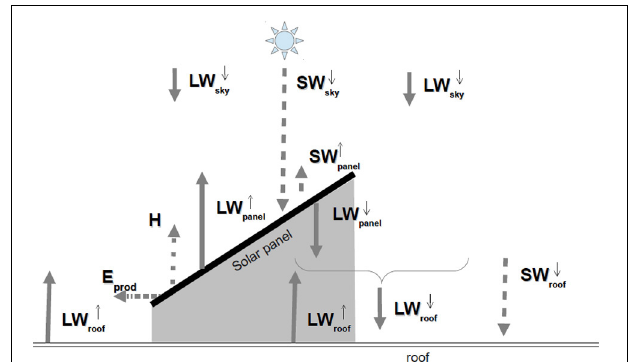
FIGURE 1 | Schematic diagram of the energy balance of the solar panel and its impact on radiation received by the roof (dashed arrows: solar fluxes; plain arrows: long-waves fluxes; dotted arrow: sensible heat flux; dotted-dashed arrow: energy produced).